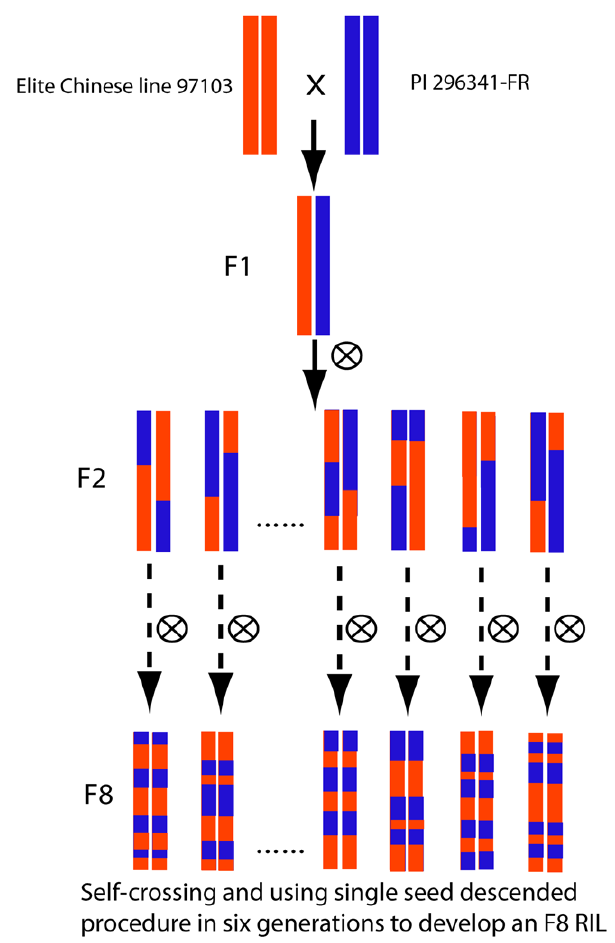
Figure 1. Construction of the RILs population.